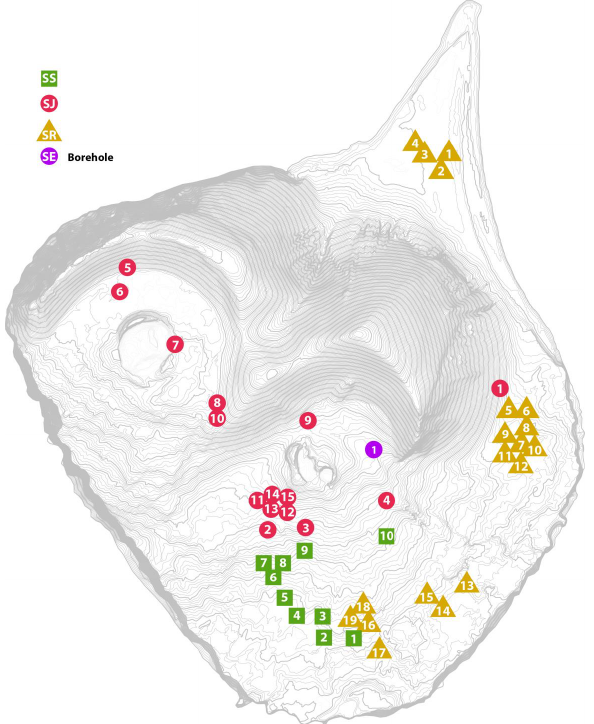
Figure 1. An overview of the sampling site. The sites are marked with green squares for sand or pumice with bird droppings sam- ples (SS), pink circles for pure sand or pumice and vegetated sam- ples (SJ), yellow triangles for partly vegetated and non-vegetated area samples (SR) collected inside squares for activity measure- ments and purple circle for the drill hole site (SE). The sampling sites are distributed according to GPS points.